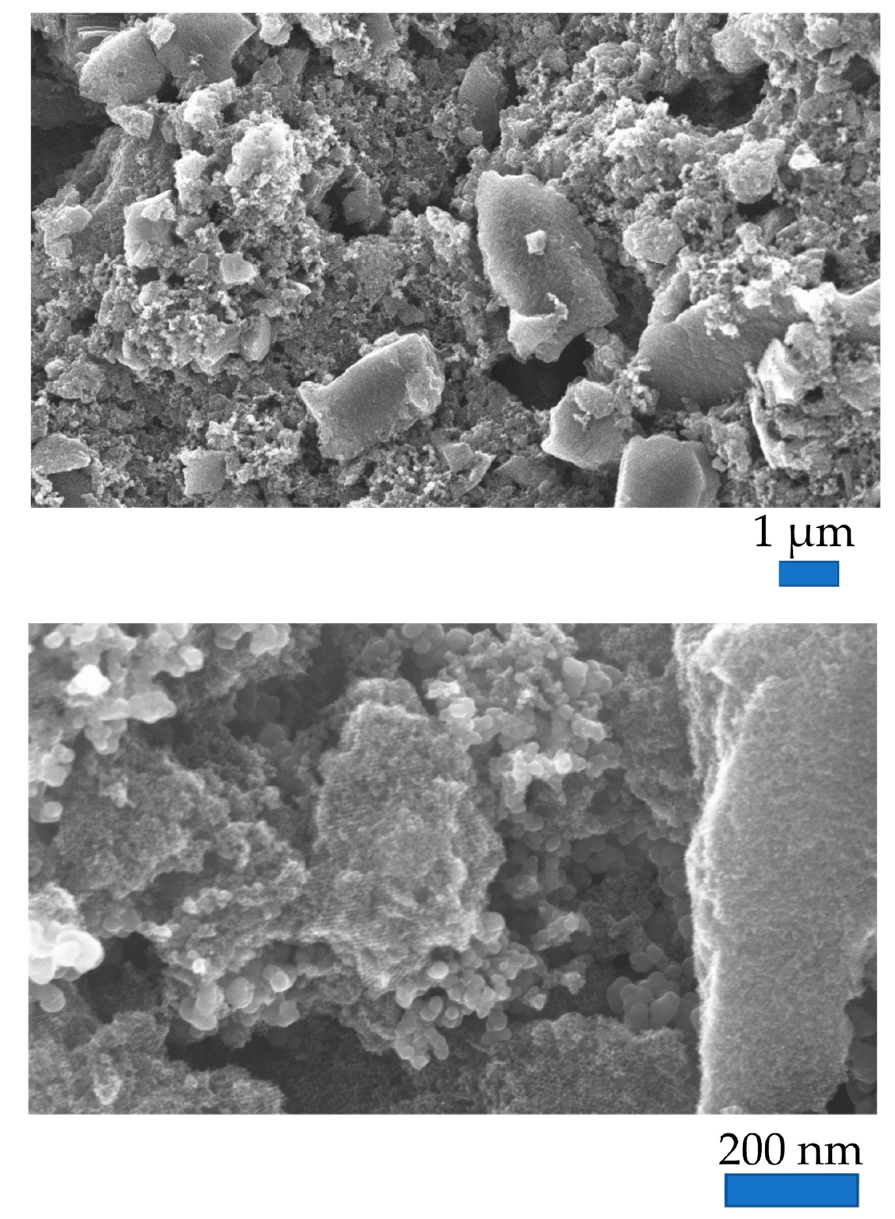
Figure A2. SEM micrographs of the N-CMK-8 composite electrodes.